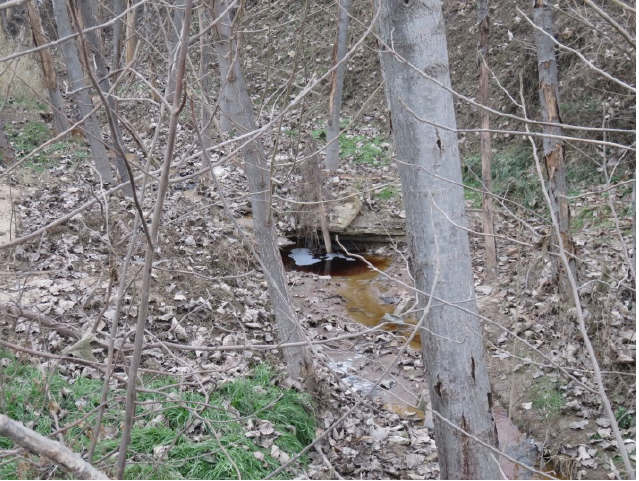
Figure 8. Polluted canals in the study